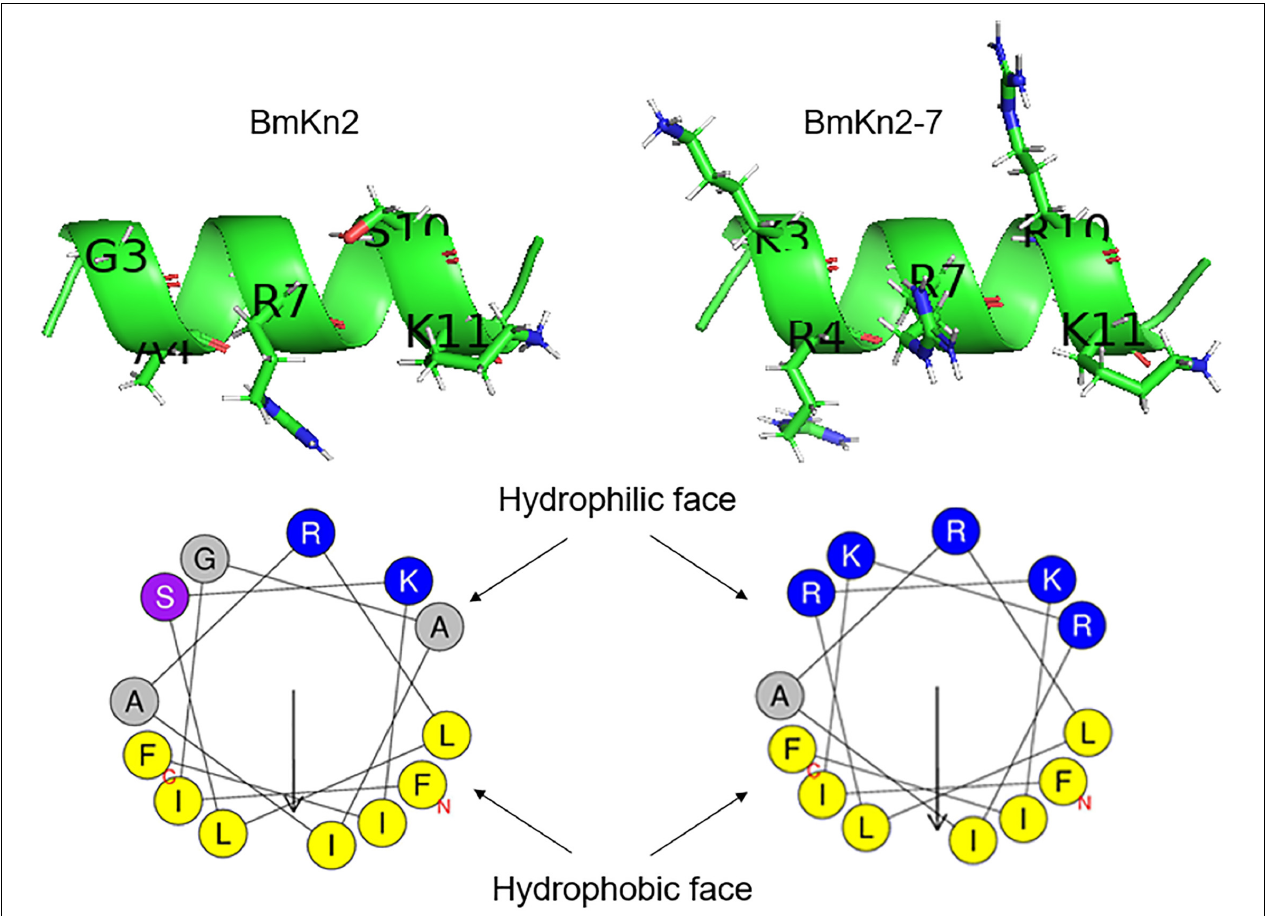
FIGURE 1 | Structural variations between the scorpion cationic α -helical antimicrobial peptide (C α AMP) BmKn2 and BmKn2-7. The three-dimensional structures and the helical-wheel plots were obtained by using the I-TASSER and HeliQuest servers, respectively. Residues of the hydrophilic faces are marked with one letter abbreviations and side chains are shown in the ribbon structures. In the helical-wheel plots, residues marked in blue and yellow represent positively charged alkaline and hydrophobic amino acids, respectively. Residue marked in purple represents Ser. Residues marked in gray represent Gly and Ala.